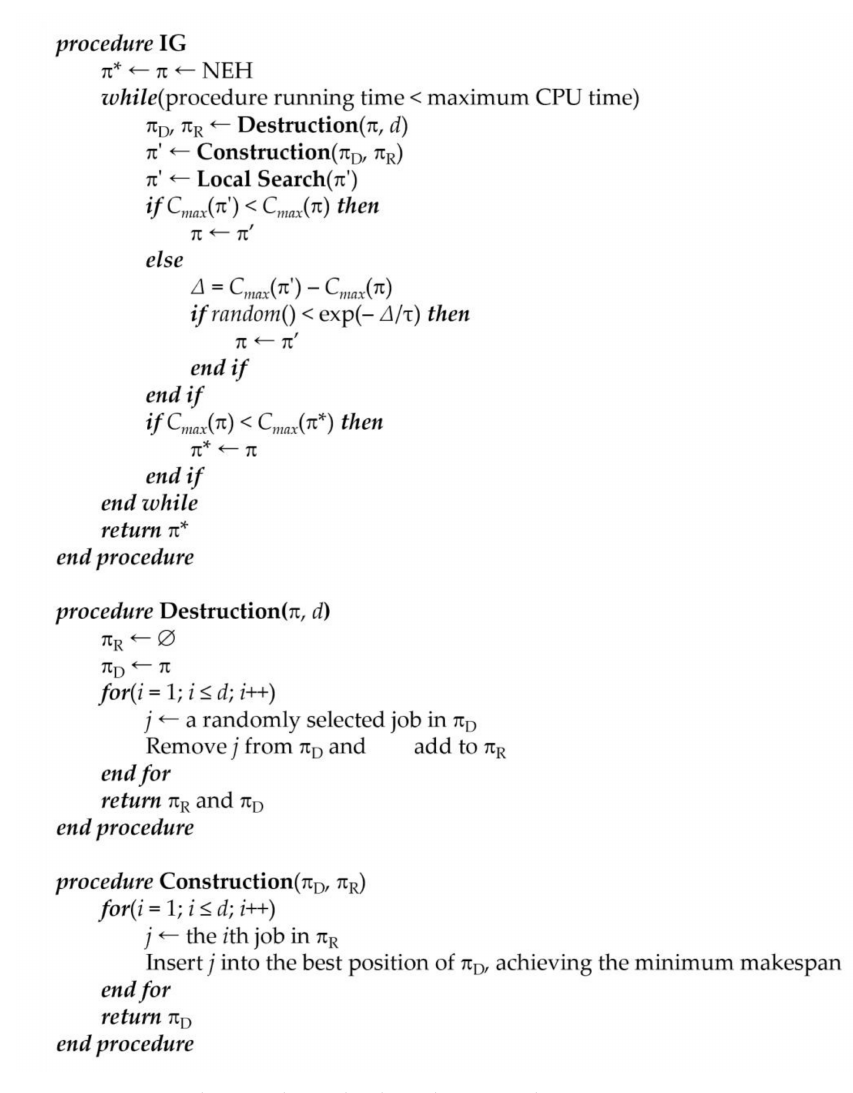
Figure 4. Proposed iterated greedy algorithm